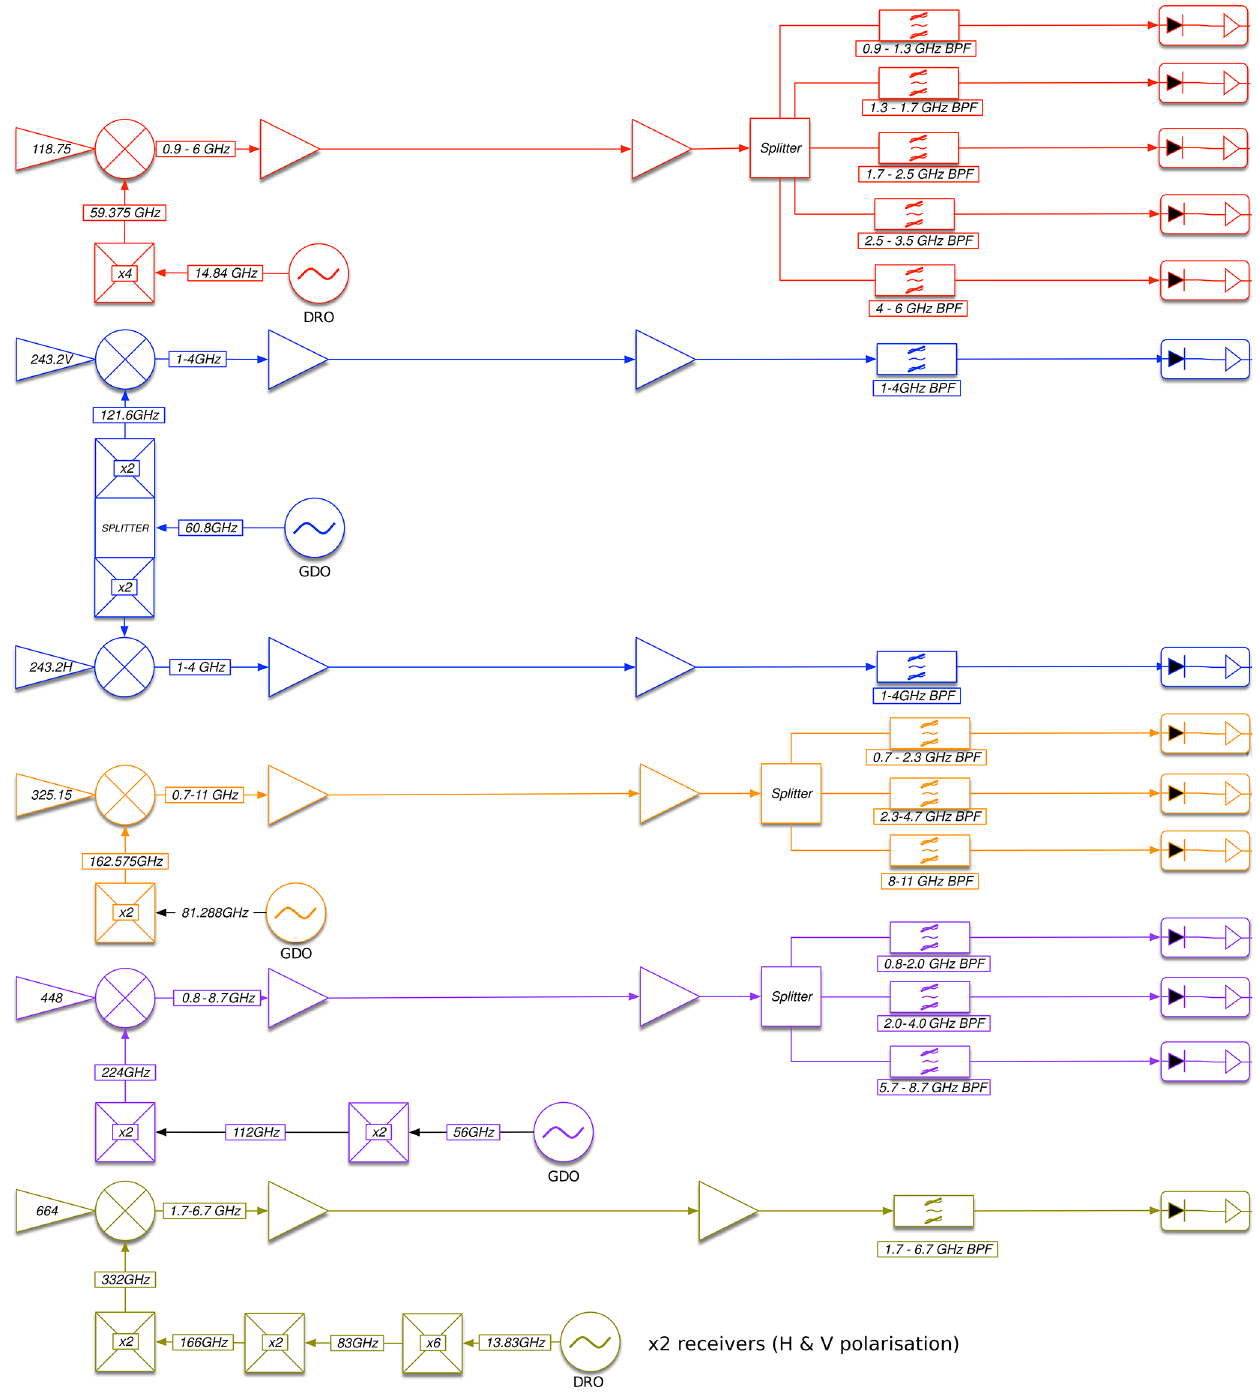
Figure 3. Schematic of the ISMAR RF